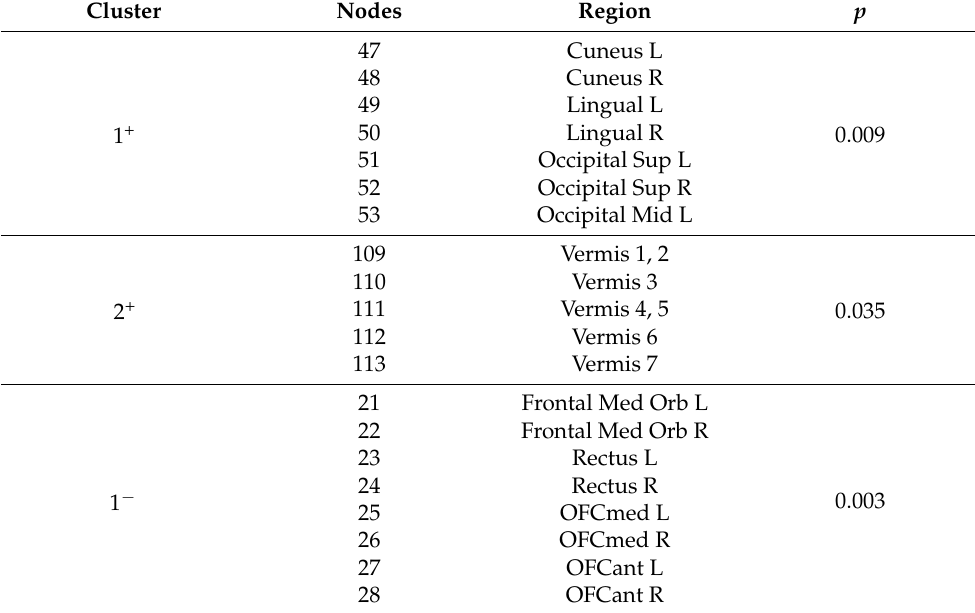
Table 5. Significant clusters for the clustering coefficient measure; here, superscripts “+” and “ − ” denote positive (Control > MDE) and negative (MDE > Control) clusters,